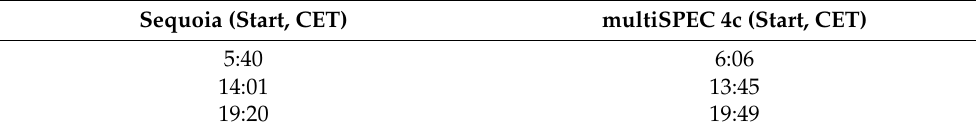
Table 4. Time schedule of all photogrammetric flights conducted on 29 July 2020.